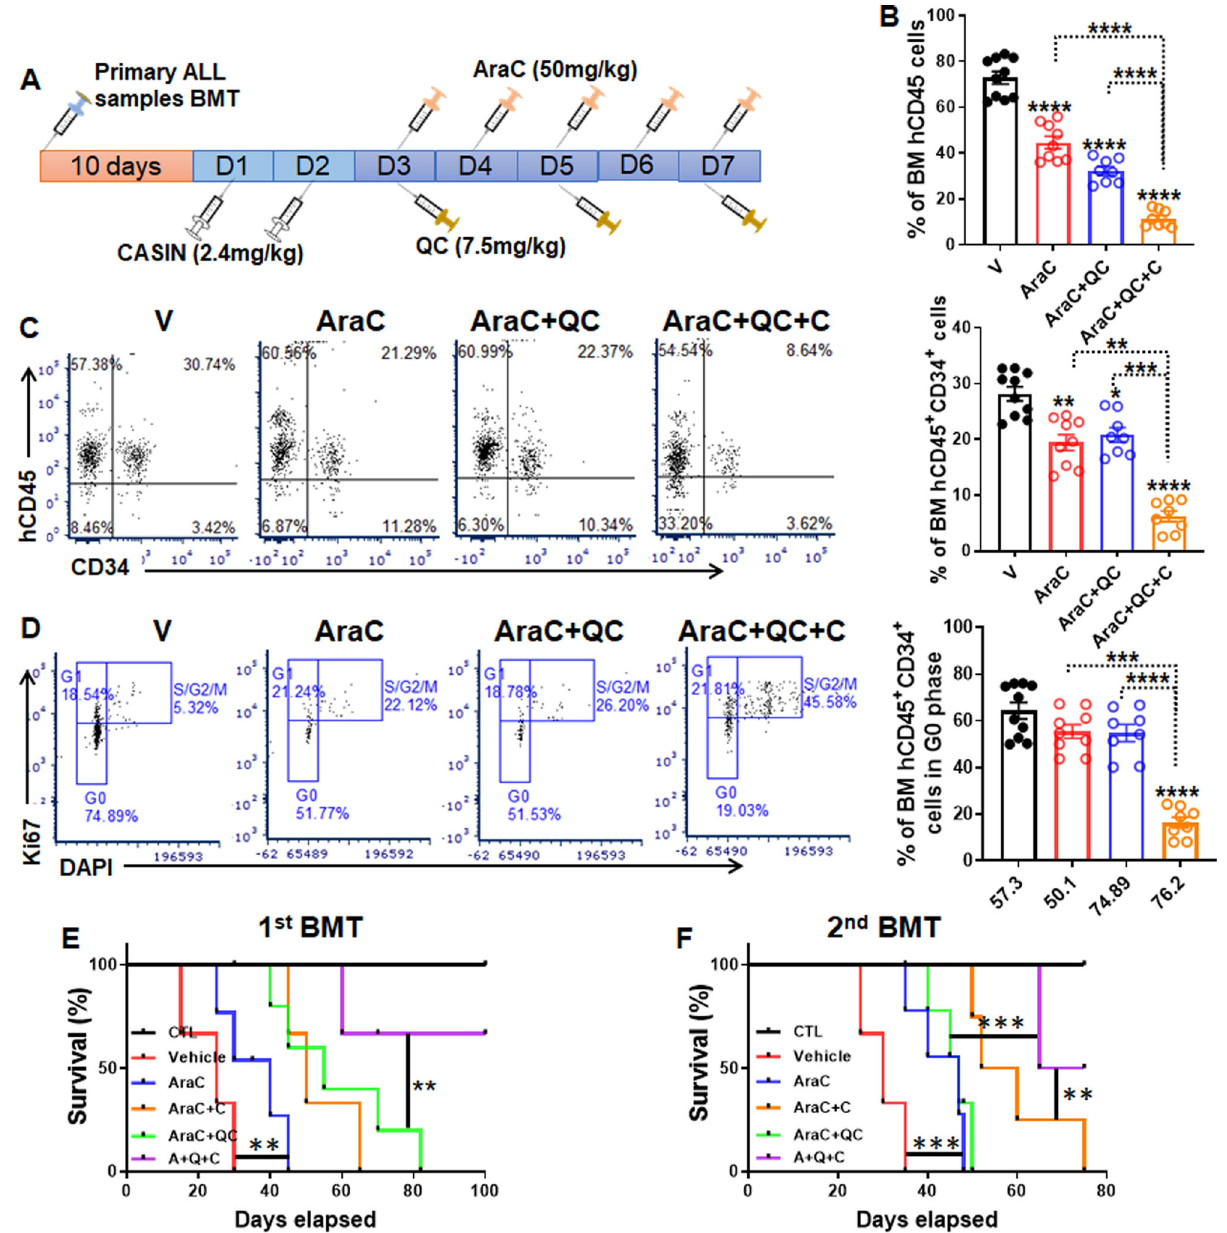
Fig. 6 CASIN enhances the eradication of ALL LSCs by AraC + QC and prolongs the survival of recipients. A Schematic presentation of experimental design. B C dc42 A ctivity S peci fi c In hibitor, CASIN decreases total hCD45 + cells in the BM of primary recipients. 1 – 2 × 10 6 primary ALL cells from